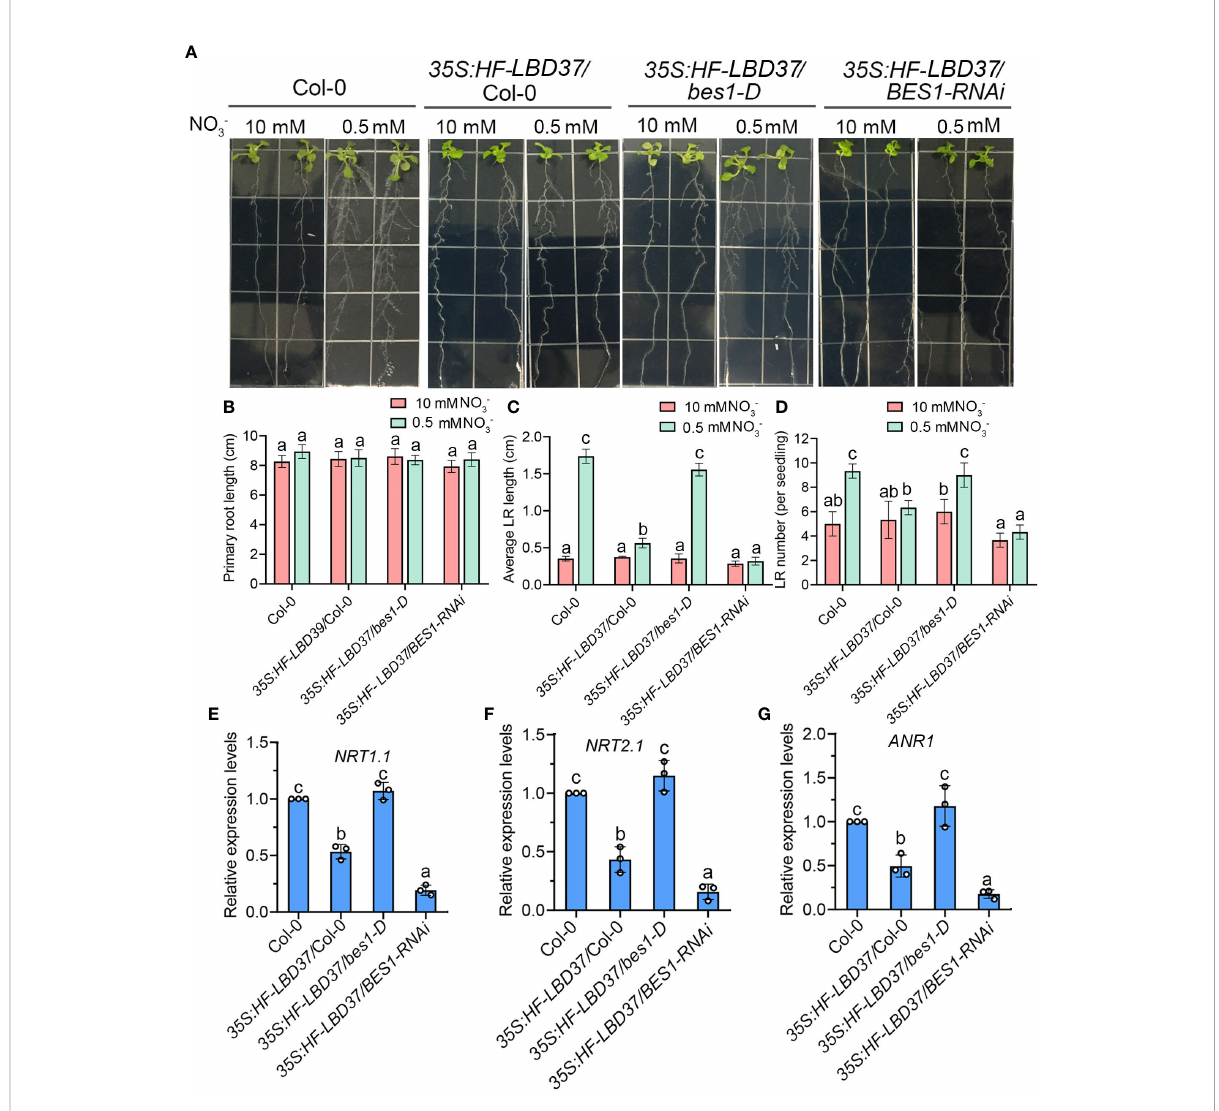
FIGURE 7 BES1 suppresses the inhibitory effect of LBD37 on lateral root growth in LN. (A) Seedling phenotypes of 35S:FLAG-HA-LBD37/ Col-0, 35S:FLAG- HA-LBD37/bes1-D and 35S:FLAG-HA-LBD37/BES1-RNAi plants. 5-day-old seedlings were precultured on medium containing 10 mM NO 3- and then transferred to HN medium or LN medium for another 9 days for quanti fi cation of primary root length (B) , average lateral root (LR) length (C) , and lateral root (LR) number (D) . Error bars indicate the s.d. (n=10-15). Different Lowercase letters above the bars indicate statistically signi fi cant differences between samples (p < 0.05, two-way ANOVA). (E-F) Expression analysis of LN-responsive genes NRT1.1 (E) , NRT2.1 (F) and ANR1 (G) in the roots of 7-day-old Col-0, 35S:FLAG-HA-LBD37/ Col-0, 35S:FLAG-HA-LBD37/bes1-D and 35S:FLAG-HA-LBD37/BES1-RNAi plants at LN. The expression levels of genes in the Col-0 seedlings were set to 1.00. Error bars represent s.d. of three biological repeats. Different Lowercase letters above the bars indicate statistically signi fi cant differences between samples (p < 0.05, one-way